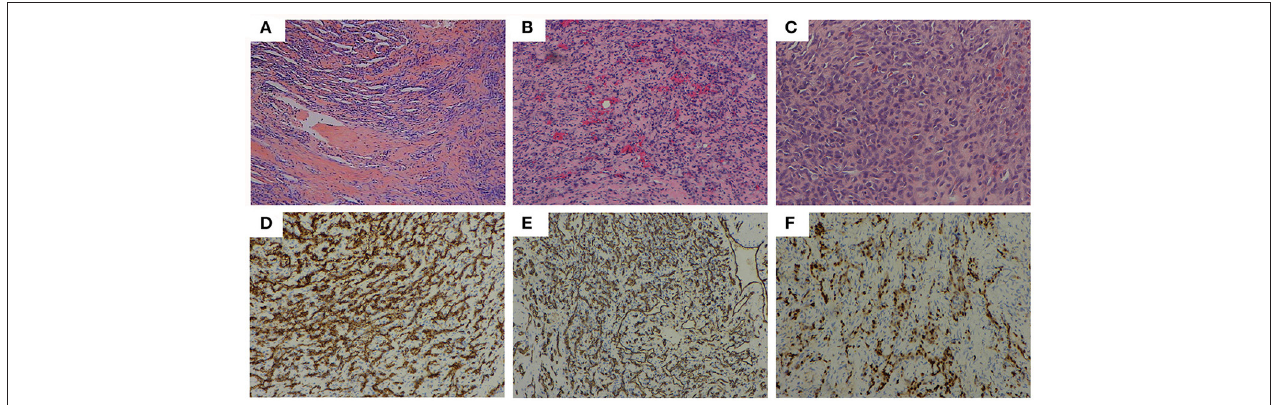
FIGURE 3 | Histopathological features: (A) (HE, × 40) the fissure-like vessel lumens lined with flattened endothelial cells among the spindle cells, (B) (HE, × 100), (C) (HE, × 200) the spindle shaped cells arranging in fascicular pattern in solid area. Immunohistochemical analysis revealing positive staining for (D) CD31 ( × 100), (E) CD34 ( × 100), and (F) ERG ( × 100) in the majority of spindle cells.